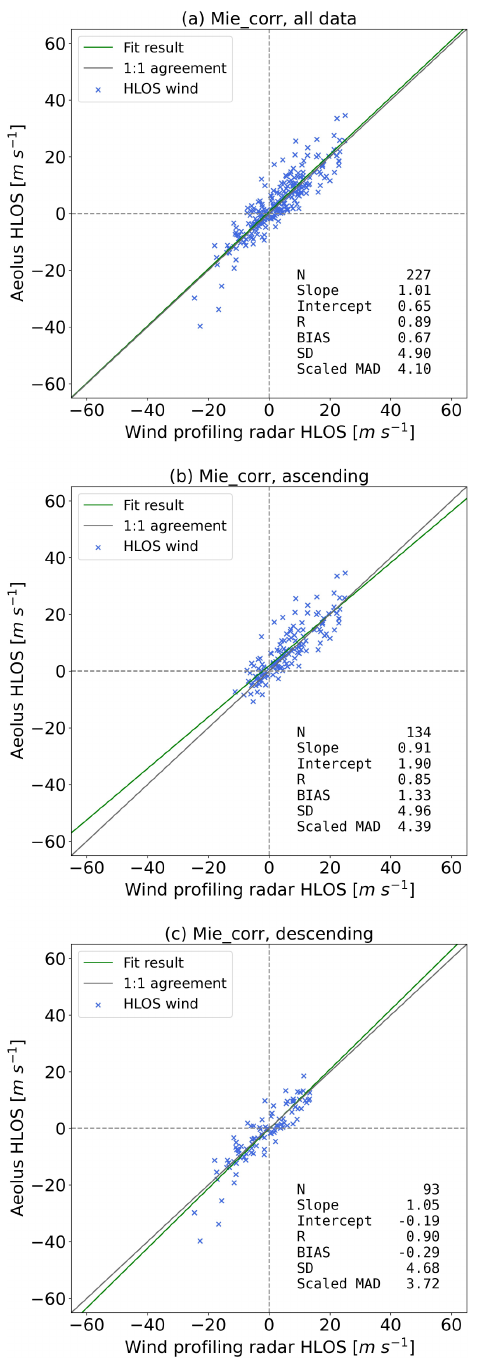
Figure A1. Scatter plots of corrected Mie-cloudy winds against WPR HLOS winds for all data (a) , ascending orbits (b) , and de- scending orbits (c) . Green and grey lines indicate the fitted regres- sion result and 1:1 agreement,